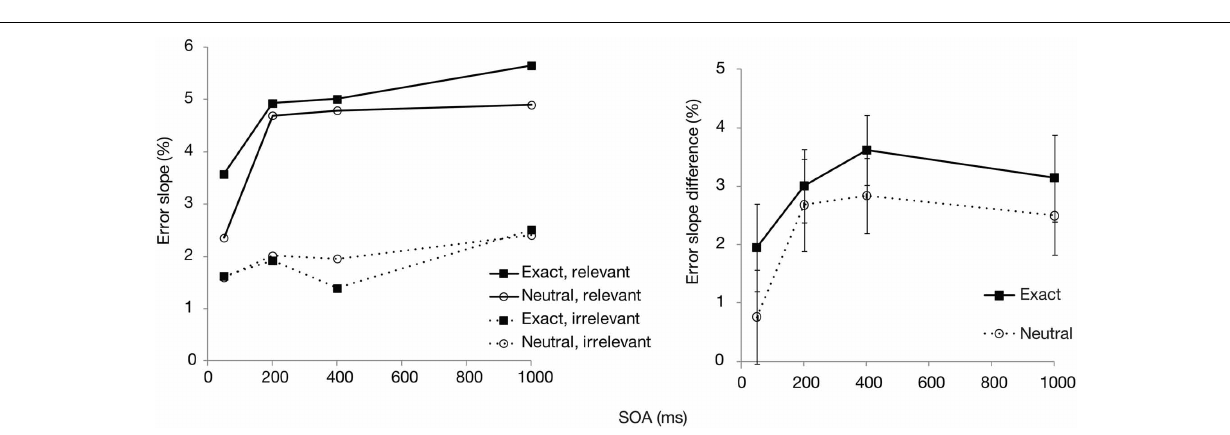
FIGURE 3 | Experiment 1: Mean error slopes for the relevant and irrelevant set, and their difference, plotted as a function of postcue type and SOA.